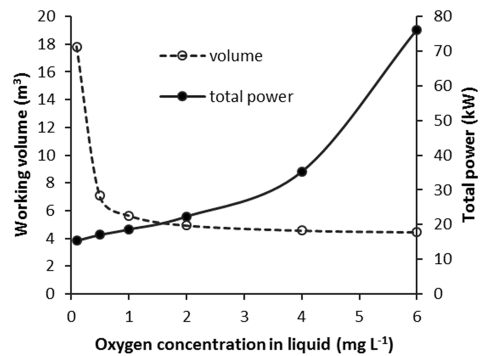
Figure 10. Effect of CSTB steady-state oxygen concentration on minimum total electrical power